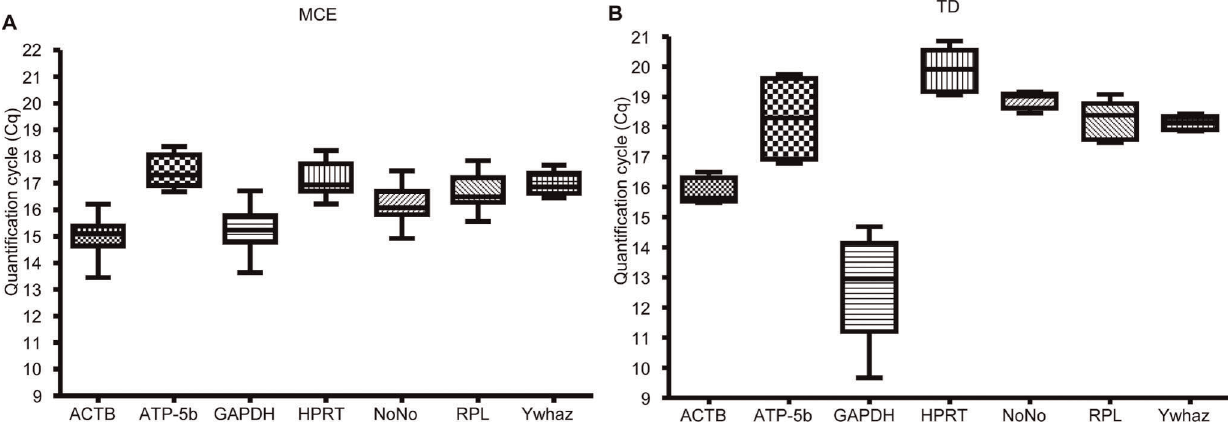
Figure 1. Distribution of qPCR quantification cycle values for the candidate RGs. qPCR gene expression analysis was carried out on cDNA derived from differentiating cells. Quantification cycles values (Cqs) were determined for the expression of ACTB, ATP-5b, GAPDH, HPRT, NoNo, RPL and Ywhaz candidate RGs during MCE (A) and TD (B). More highly expressed genes are associated with lower Cqs. doi:10.1371/journal.pone.0037517.g001 PLoS ONE |